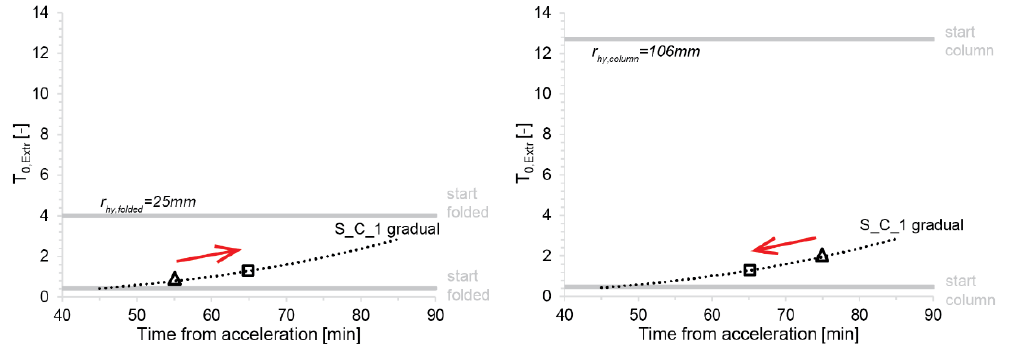
Figure 17. The process window between SDC and SDC for the start of slipping with a typical 2 SDC + 1 formwork for thin folded structures ( left ) and with a cylindrical formwork to produce columns ( right ). The red arrows highlight the slipping strategy for the start time and increased or decreased slipping time for later.